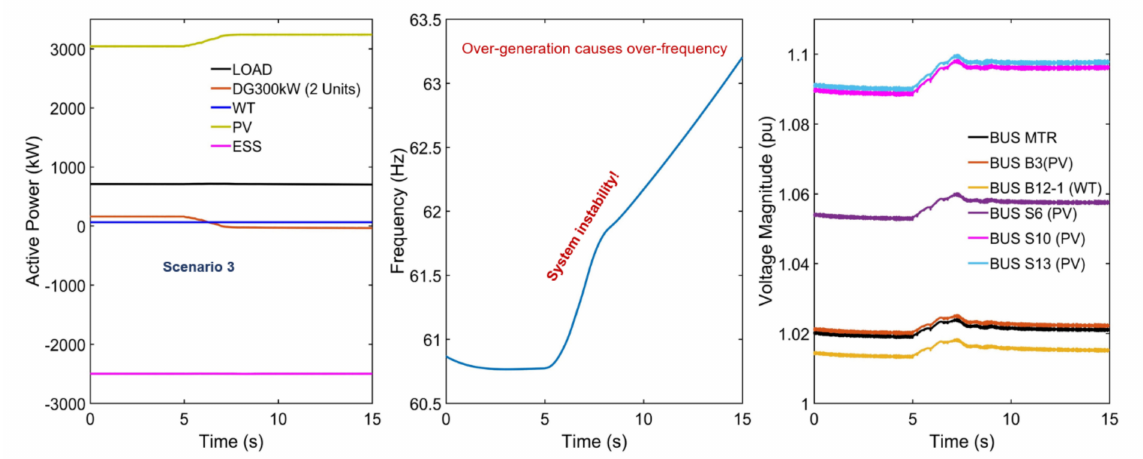
Figure 13. Active power, frequency, and voltage responses in Scenario